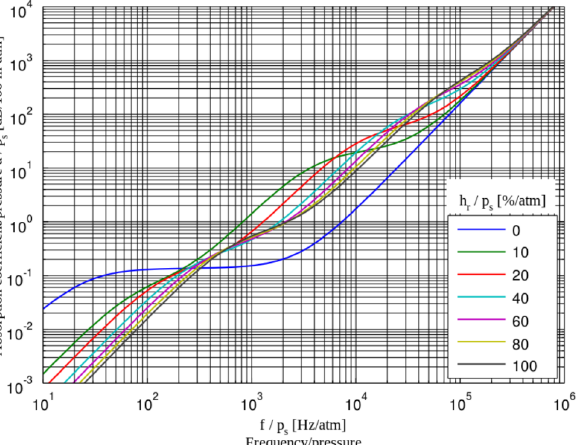
Figure 17. Sound attenuation dependent on relative humidity (RH) and frequency at 20 degrees Celsius.